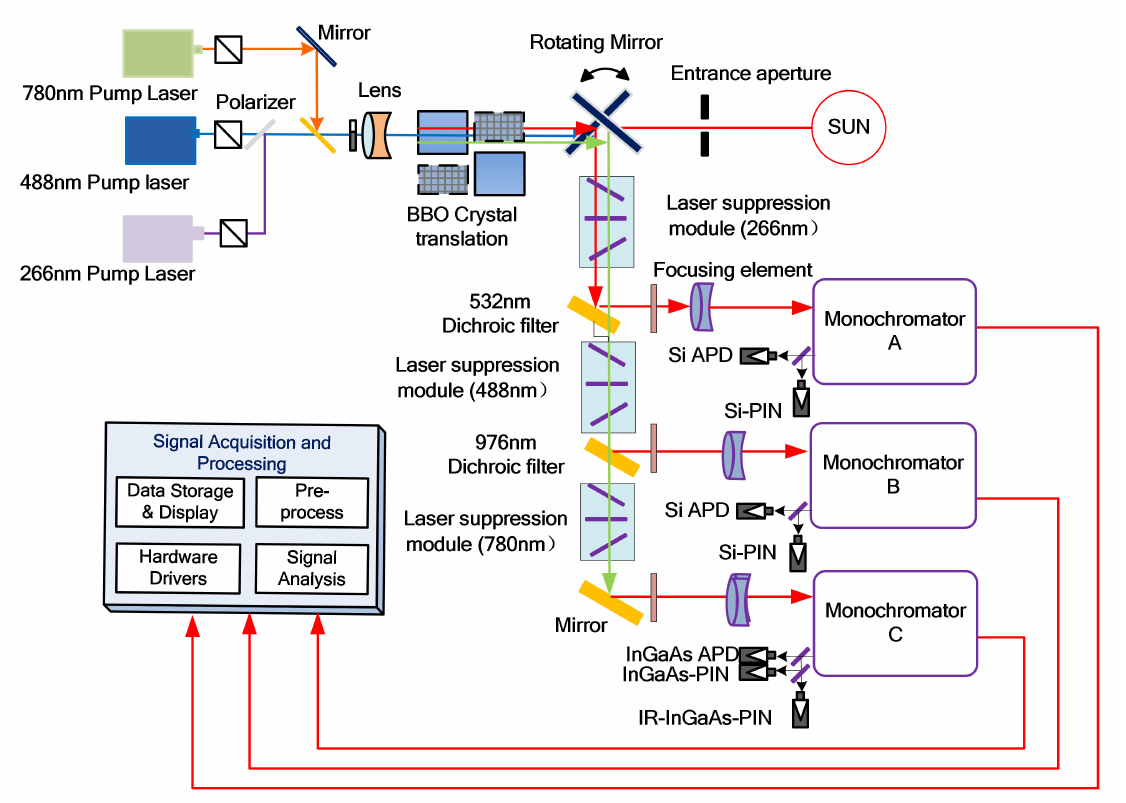
Figure 3. Schematic of a solar spectral irradiance radiometer calibrated with SPDC. Note: avalanche photodiode